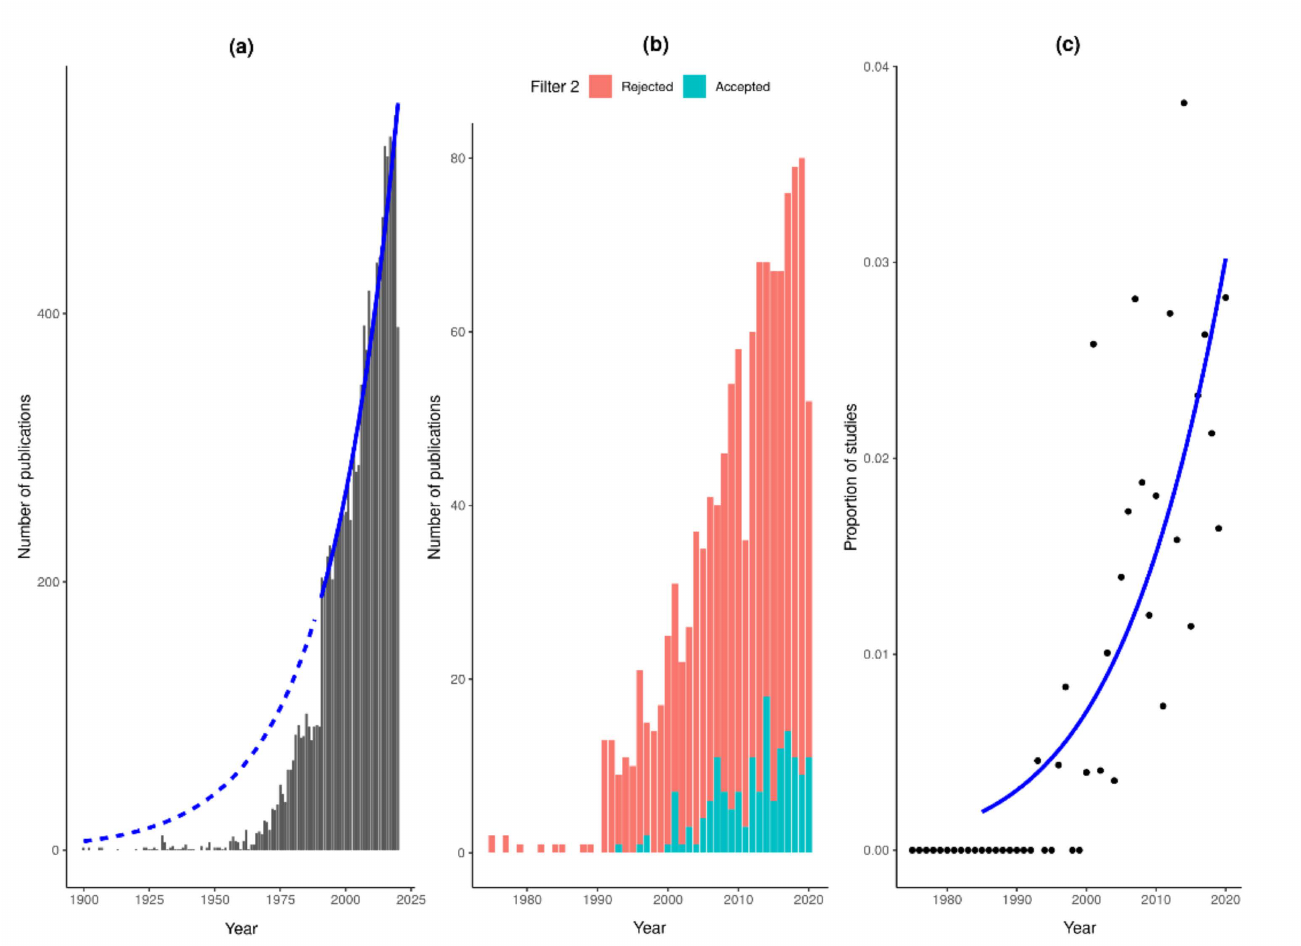
Figure 1. Trends in total number and proportion of publications per year. ( a ) Total sample of 12,699 documents with key- words related to parrots from Web of Science; the blue line indicates the modeled exponential increase in total publications per year using a GLM with a Gaussian distribution and log-link fitted to the years 1990–2020 (solid line) and extrapolated to the previous period (dashed line). ( b ) Number of publications filtered by keywords related to species distribution and manually rejected or accepted. ( c ) Proportion of studies on species distributions in relation to the total sample of publications per year (black dots), the blue line represents the modeled increase in proportion using a GLM with binomial distribution and probit link